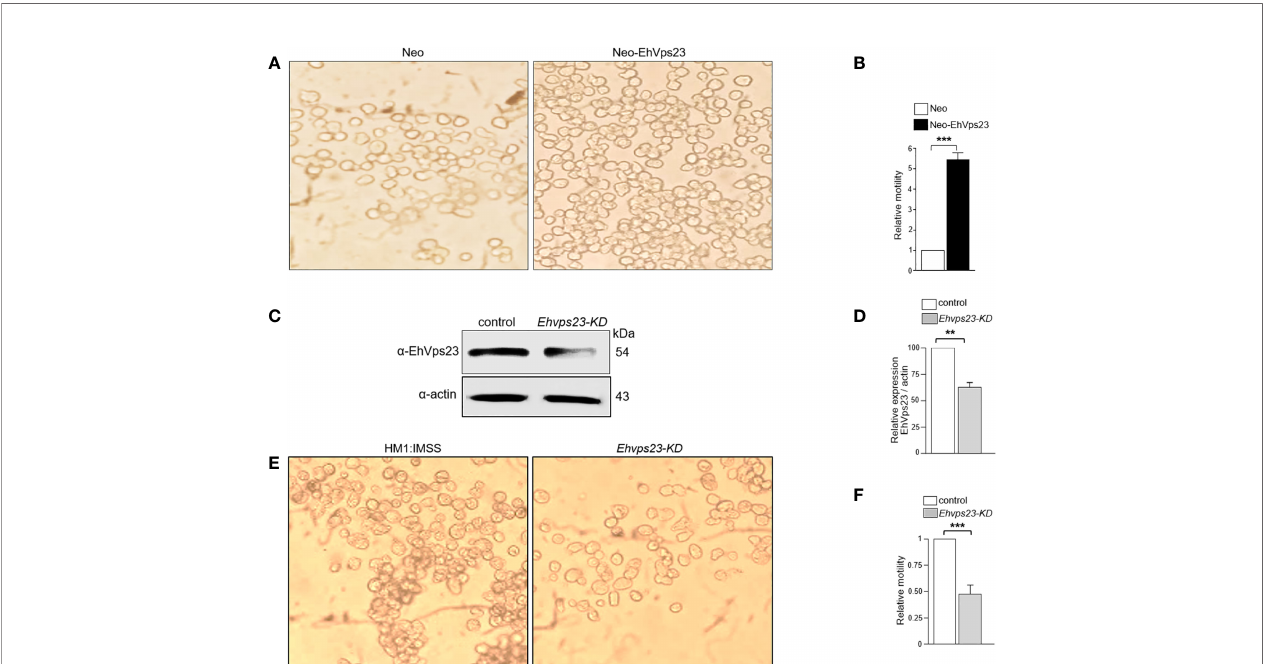
FIGURE 9 | Motility of Neo-EhVps23 and Ehvps23-KD trophozoites. The trophozoites were placed in the upper chamber of Transwell fi lters and bovine serum in the lower chamber. After 3 h the trophozoites in the lower chamber was counted. (A) Neo-EhVps23 trophozoites found in the lower chamber of the Transwell fi lters. As control we used Neo trophozoites. (B) Quanti fi cation of trophozoites in the lower chamber to obtain the relative motility of Neo-EhVps23 trophozoites with respect to the control. (C, D) Western blot of silenced trophozoites ( Ehvps23-KD ) probed with the a -EhVps23 antibodies. Densitometry at the left using a -actin as control. (E) Ehvps23- KD trophozoites found in the lower chamber of the Transwell fi lters. As control we used trophozoites of the wild type strain HM1:IMSS. (F) Quanti fi cation of trophozoites in the lower chamber to obtain the relative motility of Ehvps23-KD trophozoites with respect to the control. **P < 0.01, ***P < 0.001.